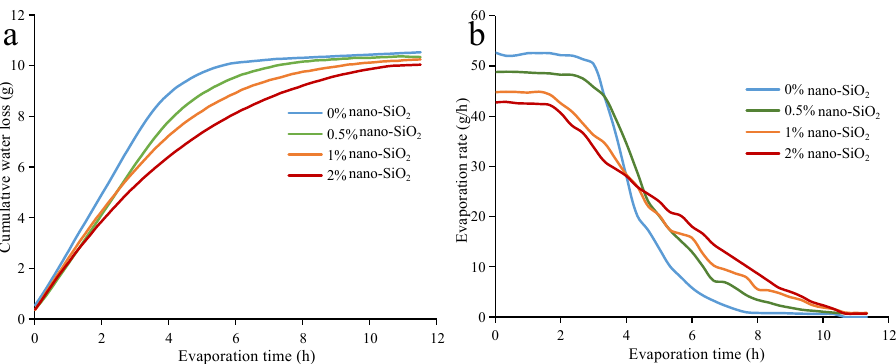
Figure 5. The ( a ) cumulative water evaporation loss and ( b ) evaporation rate of nano-SiO 2 -reinforced sandy soil.